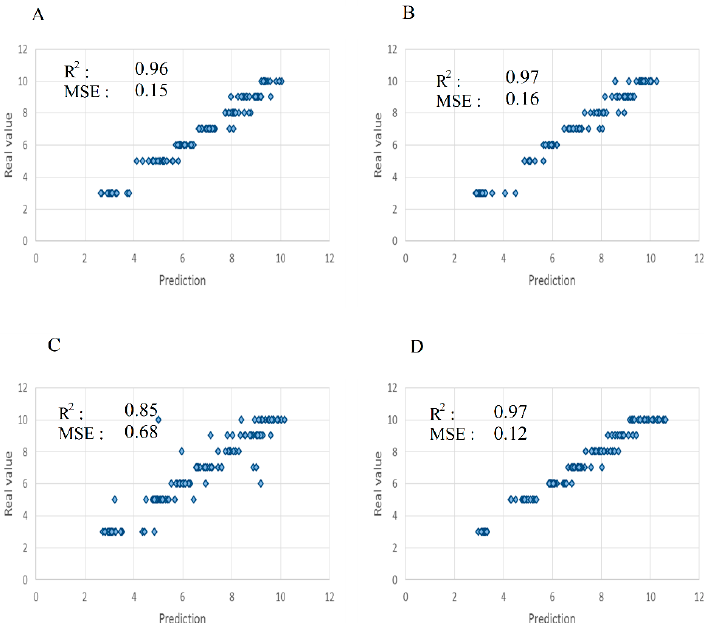
Figure 16. The real values of gas-flow rate (sccm) during the sputtering process are presented in ‘y axis and the predicted values in ‘x axis, along with R-squared (R2), and mean squared error (MSE) values of the model’s prediction. ( A ) Original min max scaled spectral data turned into a 2D matrix, ( B ) SOM generated image, ( C ) SOM_SVD generated image from the first layer singular value decomposition reconstruction of the original data, ( D ): Original_SVD image generated from the first layer of the singular value decomposition reconstruction.